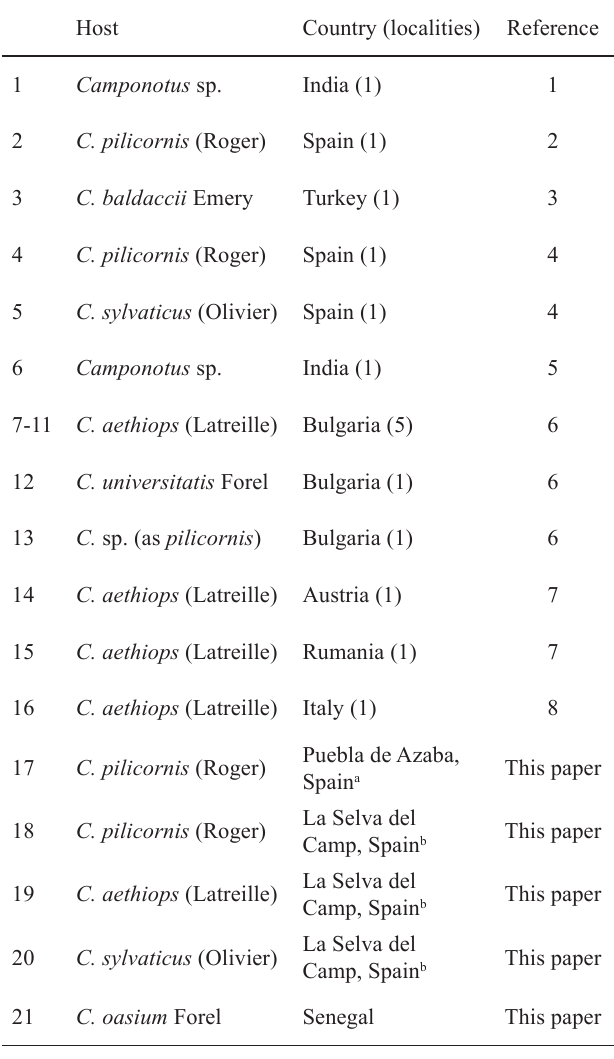
Table 1 . World records of Laboulbenia camponoti Batra. Updated to February, 2017. All specific host identifications belong in the subgenus Tanaemyrmex